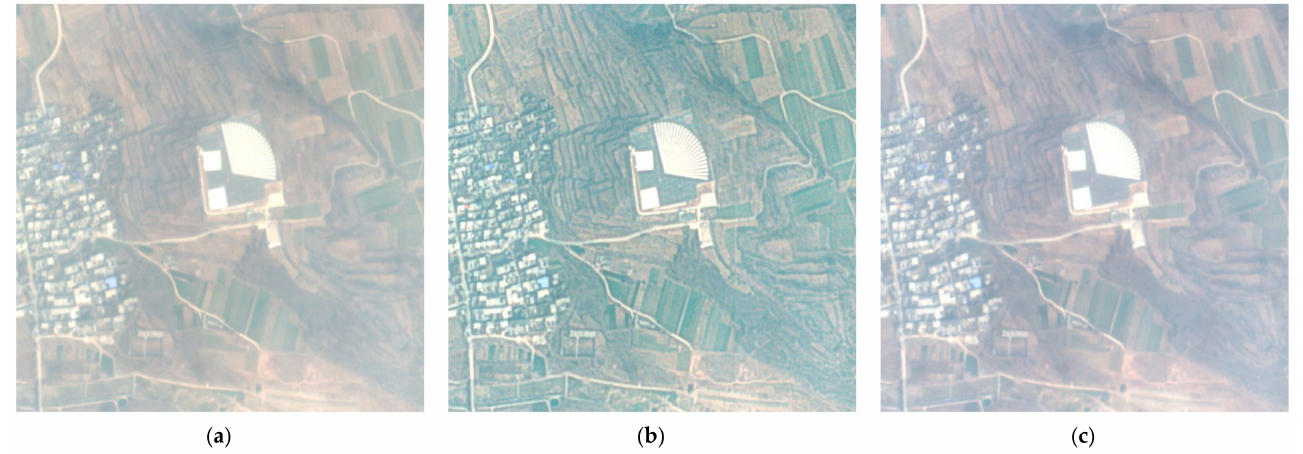
Figure 14. Images of Songshan on 8 February 2021. ( a ) Original image; ( b ) corrected image after Syn-AC; ( c ) corrected image after FLAASH. The retrieved AOD at 550 nm and retrieved CWV are 1.19, and the CWV of 0.72 g/cm 2 , respectively.